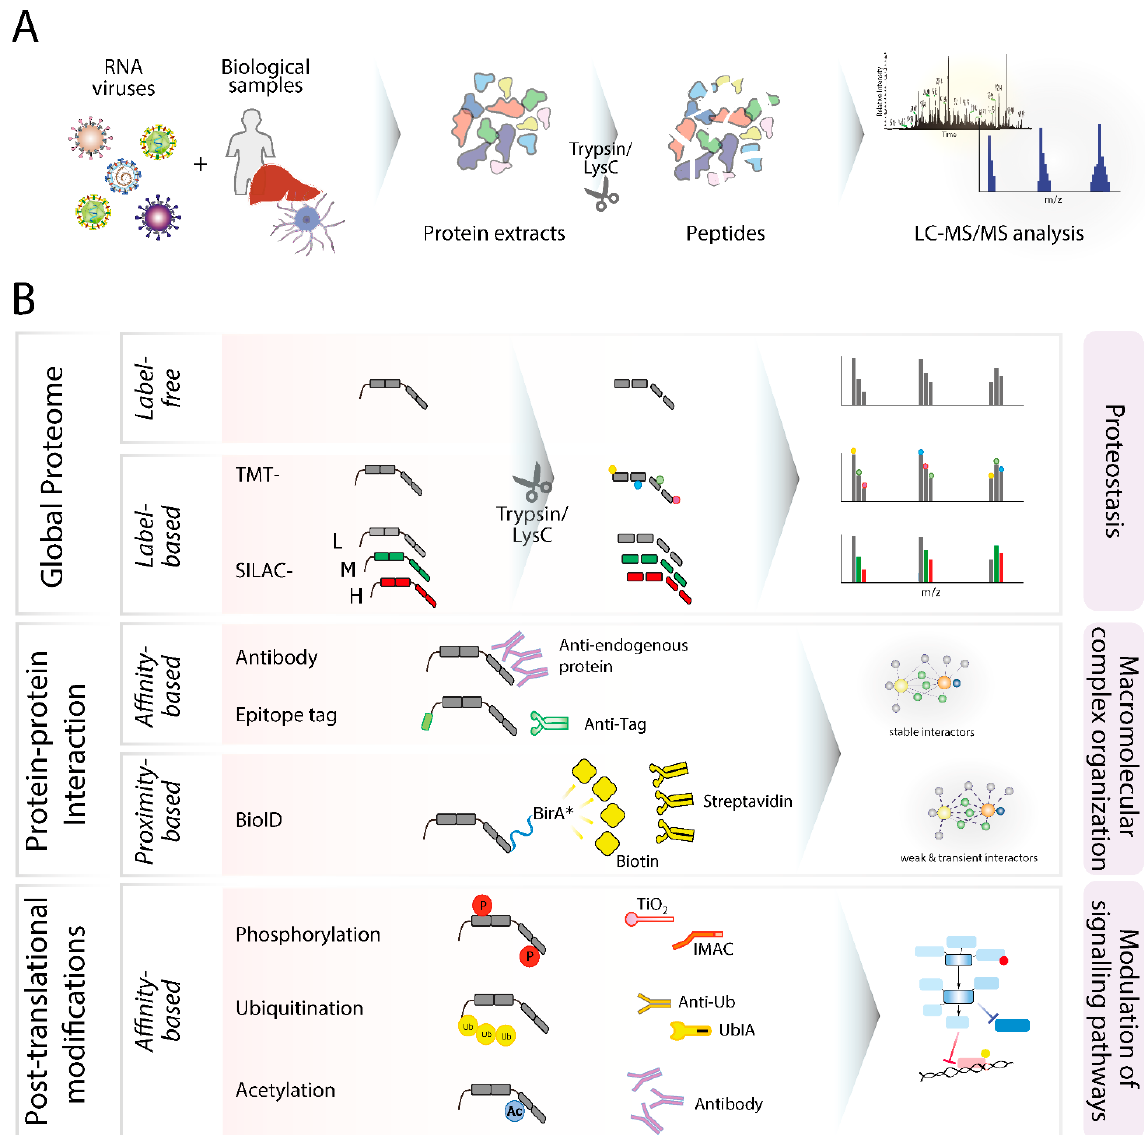
Figure 2. Bottom-up proteomics methods in RNA-virus biology. ( A ) Schematic work-flow of a prototypical bottom-up proteomics experiment. Virus-infected biological samples such as cells, tissue biopsies, or serum undergo protein extraction. Protein lysates are subjected to enzymatic digestion with proteases such as trypsin and/or LysC, and the resulting proteolytic peptides are analyzed by liquid chromatography coupled to mass spectrometry (LC-MS/MS). ( B ) Applications and main features of different bottom-up proteomics workflows. Schematic representation of commonly employed label-free and label-based stable isotope labeling by amino acids in cell culture (SILAC) and tandem mass tag (TMT) MS methods applied for global proteome profiling of different RNA viruses. Bottom-up proteomics workflows can be coupled with affinity purification (AP)-based methods to elucidate viral–host protein interaction networks. In addition, proximity-based methods such as BioID can be used to effectively identify transient or weak interactions between viral and host proteins. Bottom-up proteomics is also increasingly used to elucidate virus-induced modulation of signaling pathways through global analysis of post-translation modifications (PTMs), including phosphorylation, ubiquitination, and acetylation. Methods to enhance the analytical depth of PTM profiling include TiO 2 and IMAC for phosphorylated proteins, anti-ubiquitin antibody and UbIA for ubiquitinated proteins, and anti-acetyl-lysine antibody for acetylated